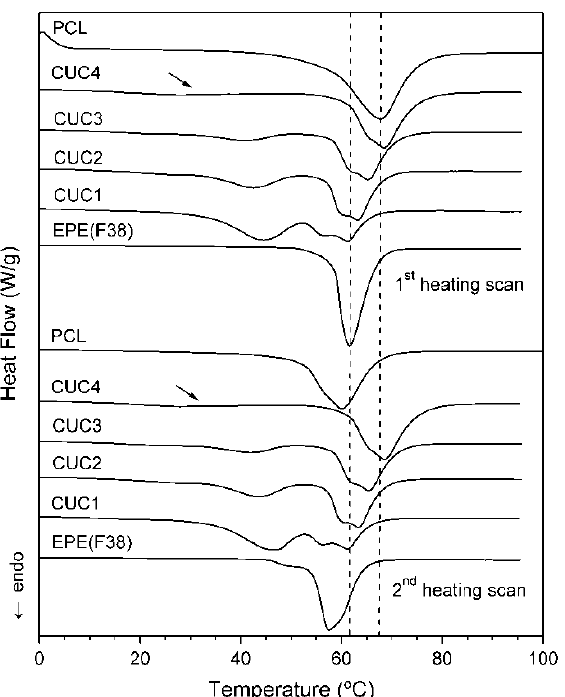
Figure 4. Dependence of M n CUC with degree of polymerization. (cid:3252)(cid:3270)(cid:3252)